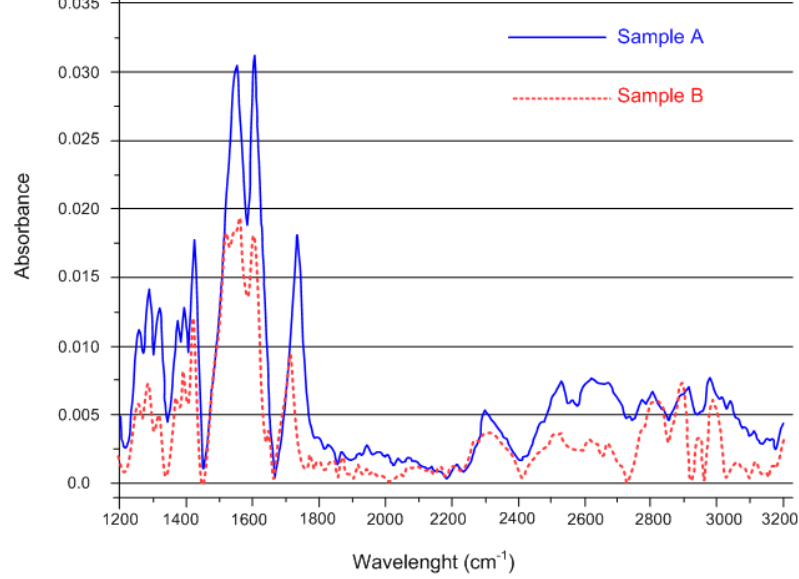
Figure 3. Comparison between IR spectra of two samples of iron citrate powder. Samples A and B are two independent replicates.